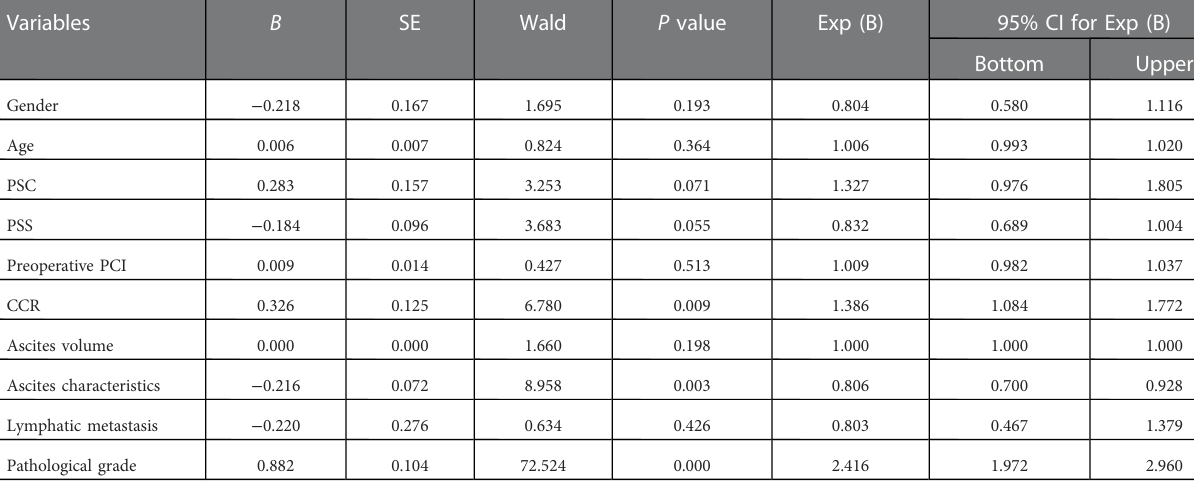
TABLE 3 Multivariate analysis affecting overall